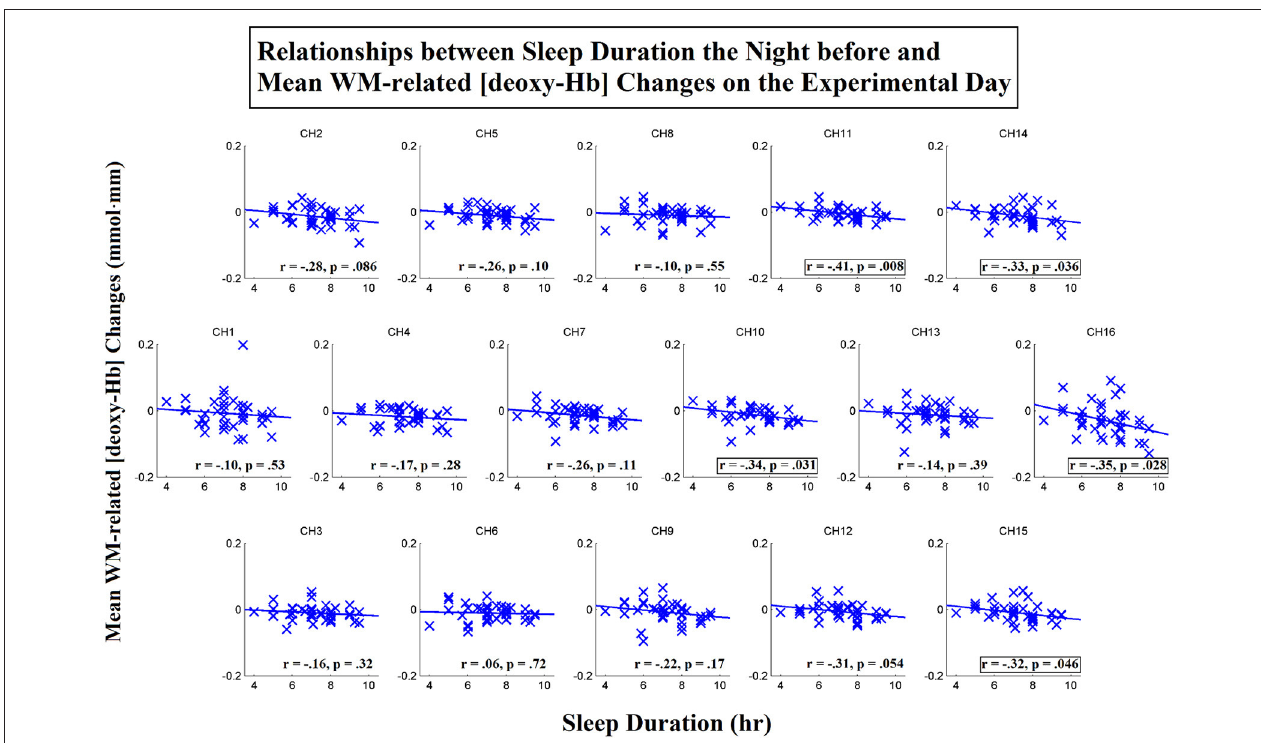
FIGURE 7 | Correlations between sleep duration the night before and mean working-memory-related (WM-related, i.e., 3-back > 0-back) [deoxy-Hb] changes on the experimental day. Pearson’s correlation coefficient ( r ) was calculated for each channel, and a linear regression line was fitted to each channel. Channels that exhibited marginally significant correlations are denoted by square borders (ch10-11,14-16; uncorrected; p s < 0.05;